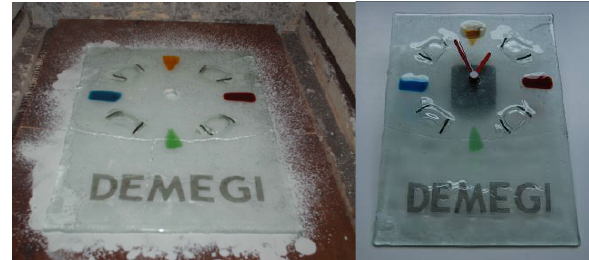
Figure 2. Glass fusing technique to manufacture a wall clock. The white powder is a demolding agent (boron nitride).